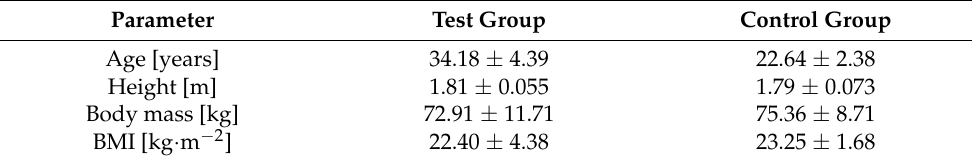
Table 3. Classification points, spinal cord injury level, American Spinal Injury Association (ASIA) Impairment Scale and training experience of the subjects with spinal cord injury.